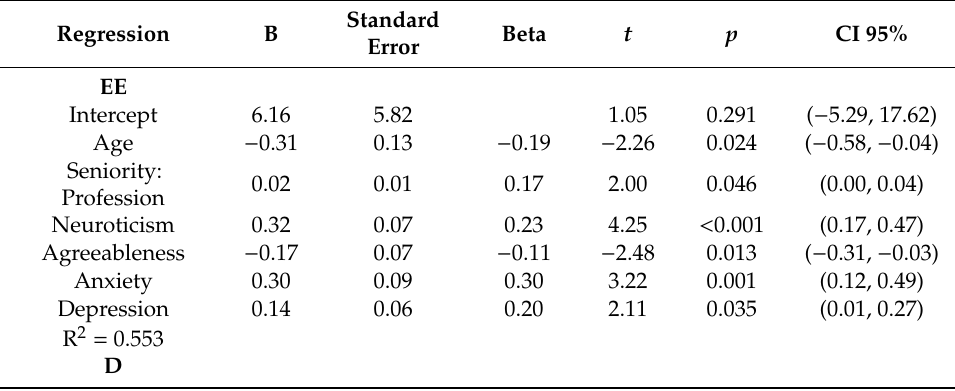
Table 5. Multiple linear